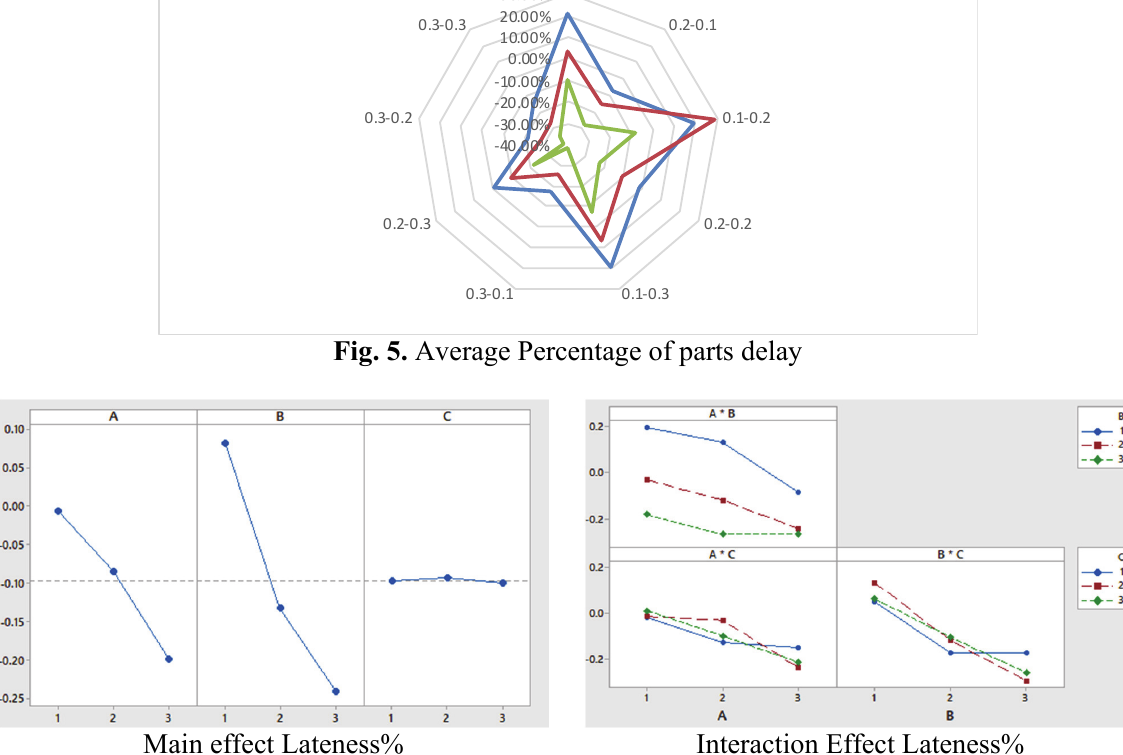
Fig. 6. Effects analysis Average Percentage of parts delay